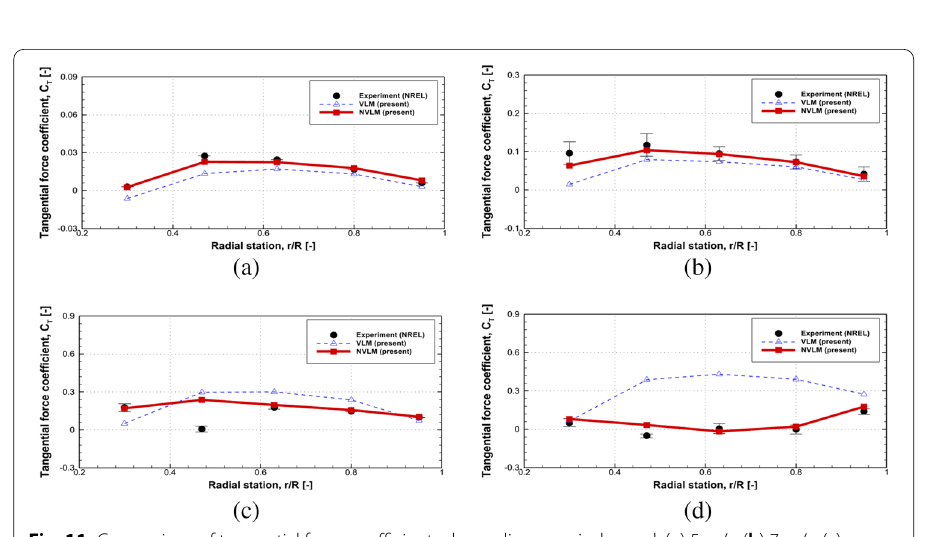
Fig. 11 Comparison of tangential force coefficients depending on wind speed: ( a ) 5 m/s, ( b ) 7 m/s, ( c ) 10 m/s, and ( d ) 15 m/s